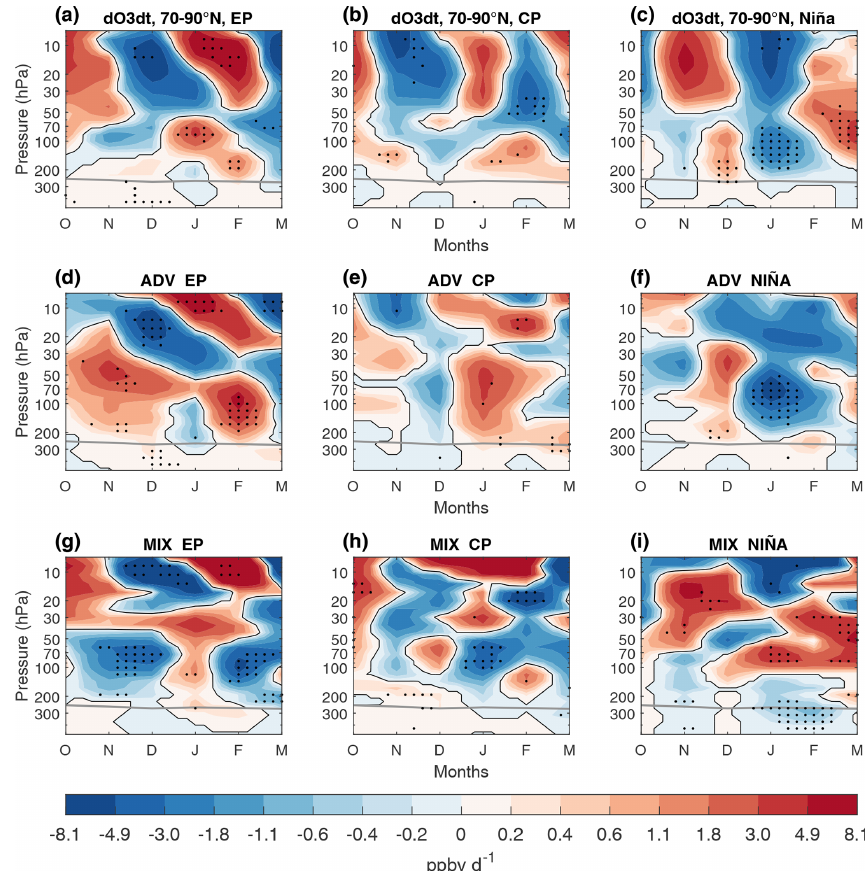
Figure 7. As in Fig. 5 but averaged over 70–90 ◦